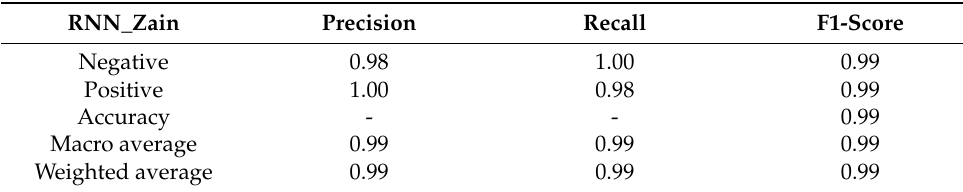
Table 8. Confusion matrix obtained by RNN on the Zain dataset.